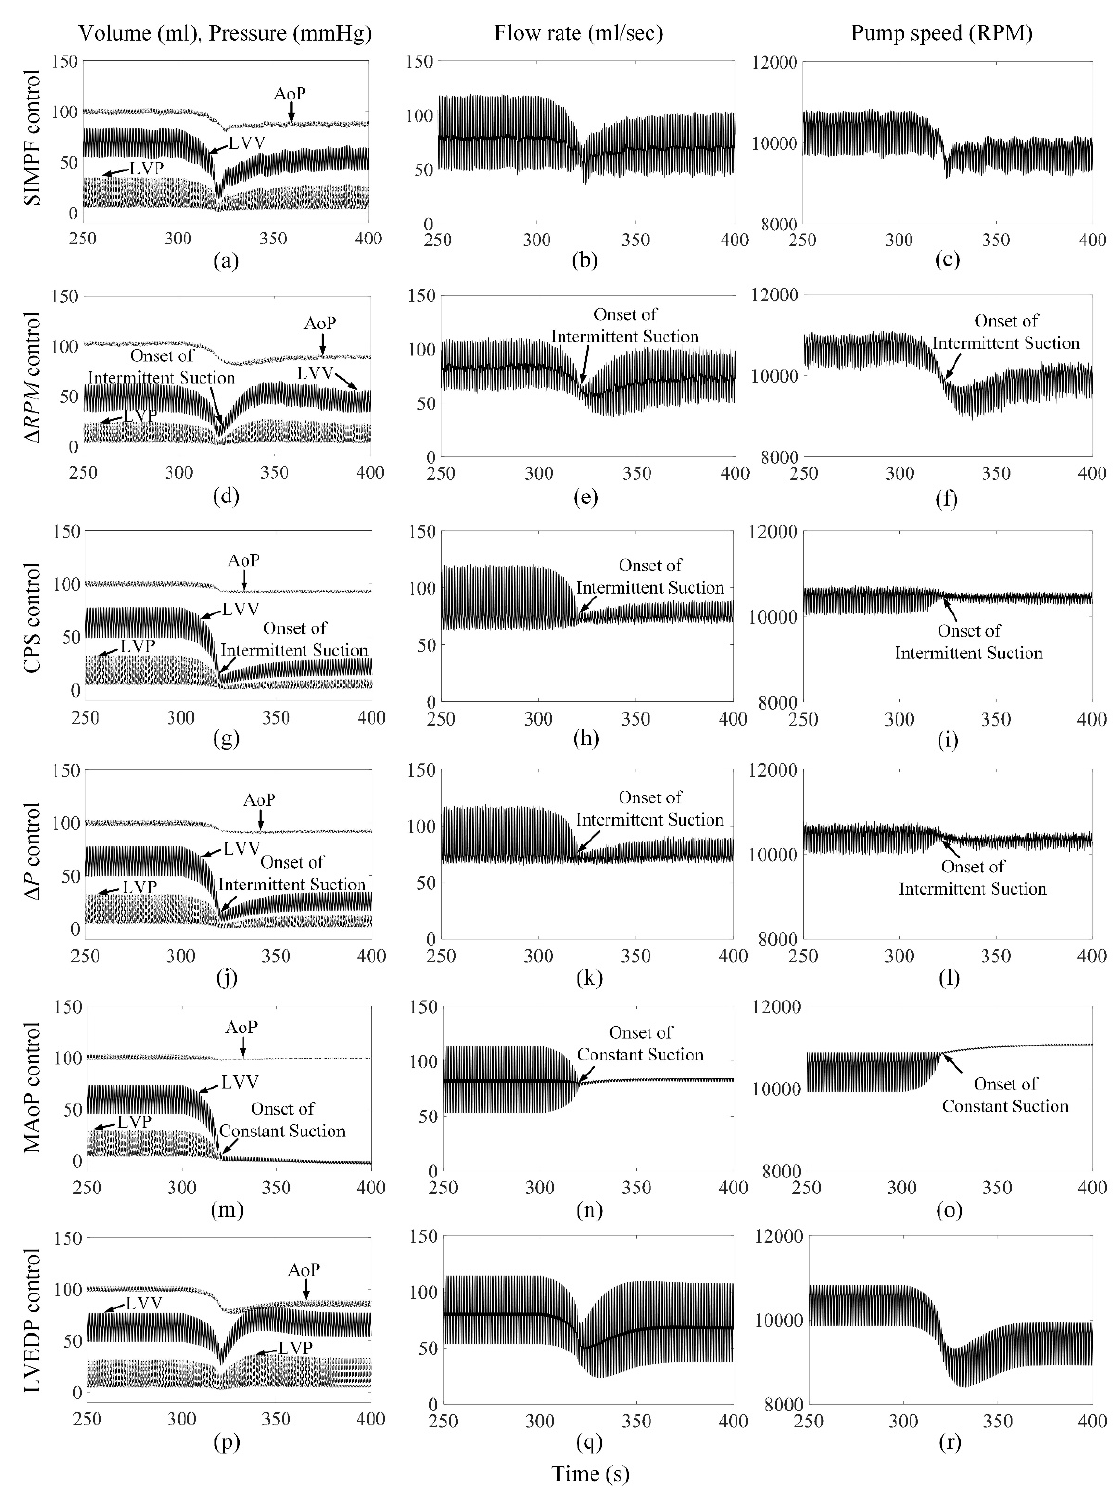
Figure 3. Comparison of performance among six control strategies at rest when the PVR increased eight times for AFP. The increase in PVR started when t = 300 s. ( a − c ) SIMPF control with 5% noise. ( d − f ) ∆ RPM control. ( g − i ) CPS control. ( j − l ) ∆ P control. ( m − o ) MAoP control. ( p − r ) LVEDP control. SIMPF and LVEDP control did not cause any LV suction. ∆ RPM , CPS, and ∆ P control induced intermittent suction. MAoP control induced constant suction.